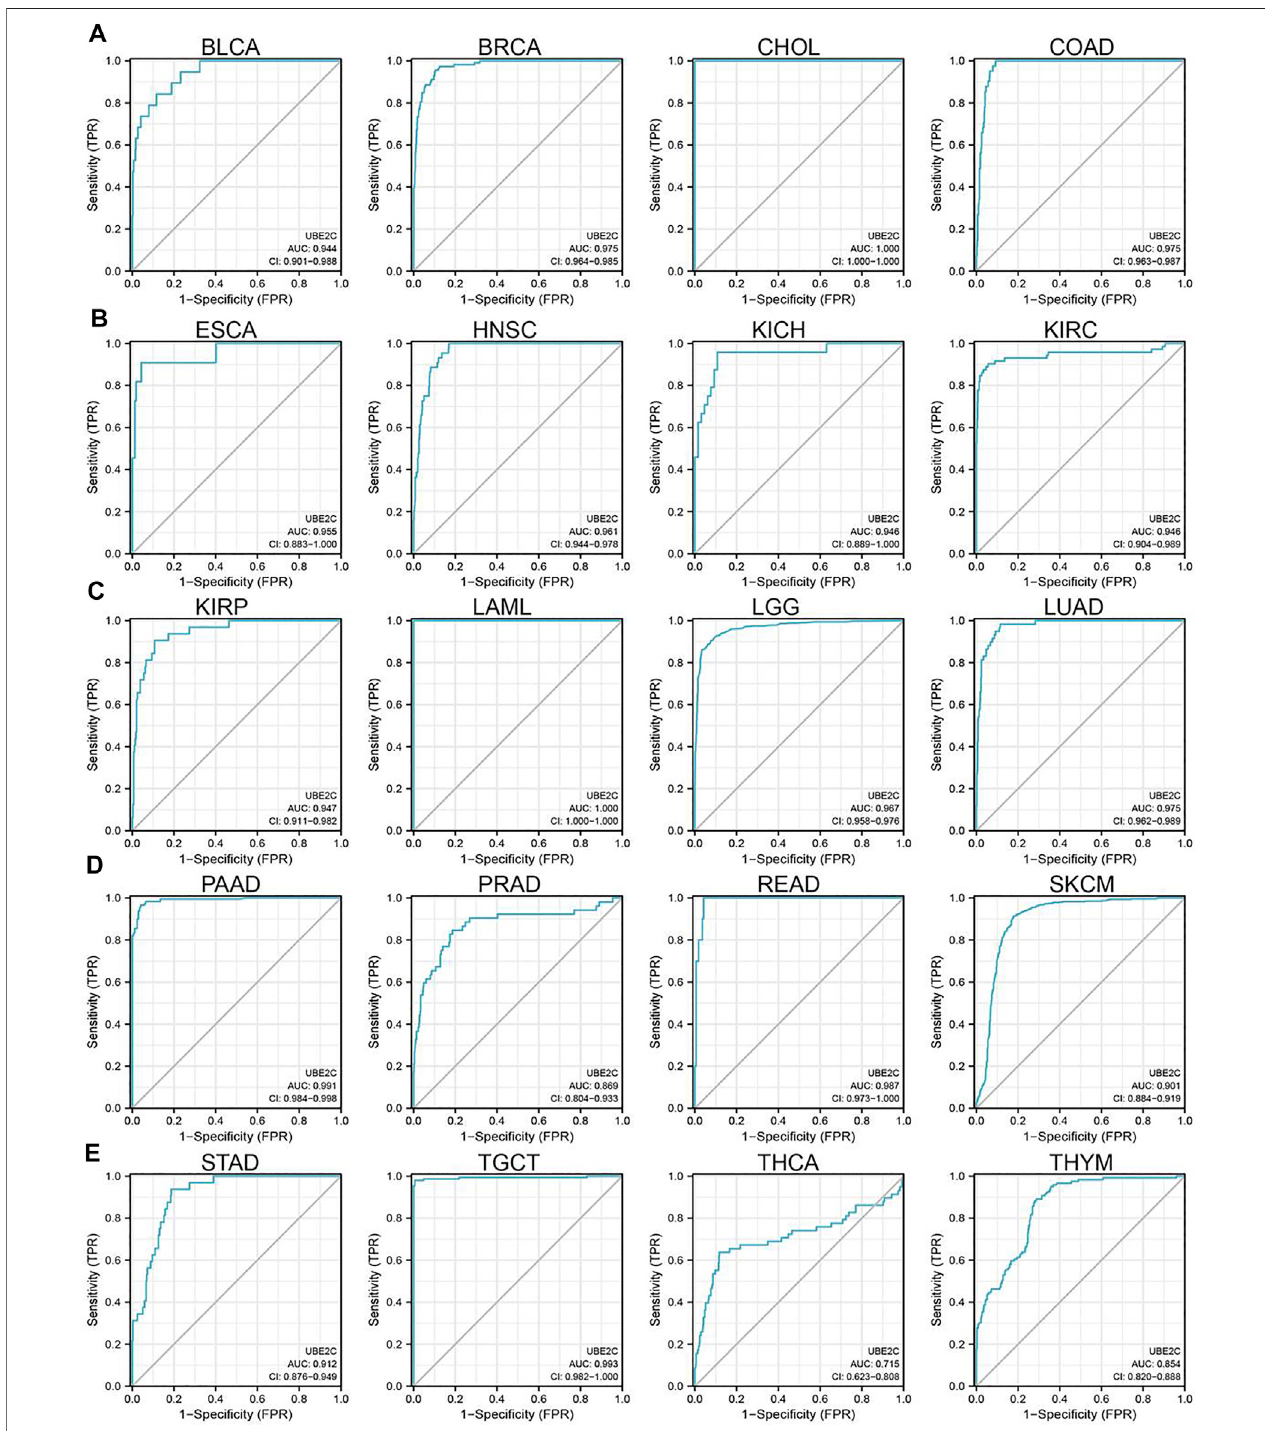
FIGURE 4 | ROC curve analyses and AUC values for UBE2C in diverse cancer. (A) ROC curve analysis and AUC values for UBE2C in BLCA, BRCA, CHOL, and COAD. (B) ROC curve analysis and AUC values for UBE2C in ESCA, HNSC, KICH, and KIRC. (C) ROC curve analysis and AUC values for UBE2C in KIRP, LAML, LGG, and LUAD. (D) ROCcurveanalysisand AUCvalues forUBE2CinPAAD, PRAD, READ,and SKCM. (E) ROCcurveanalysisand AUCvalues forUBE2CinSTAD, TGCT, THCA, and THYM.